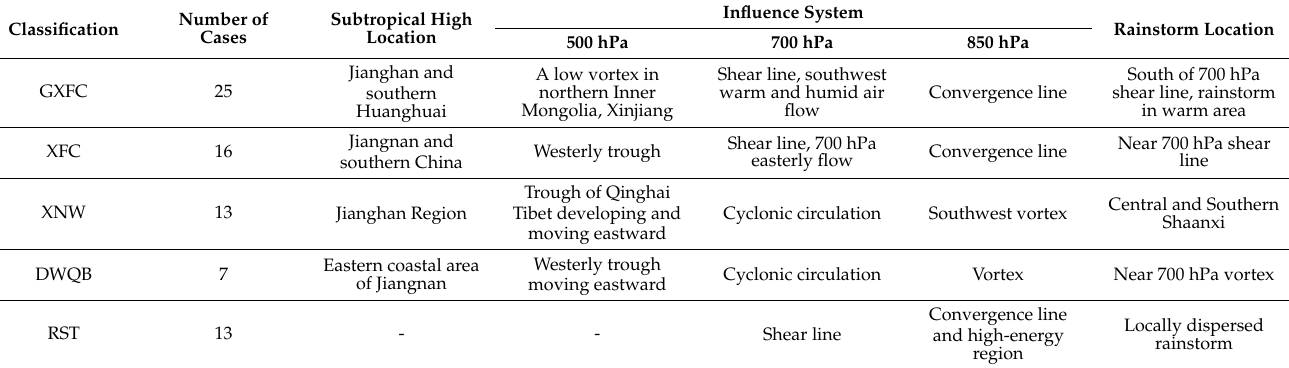
Table 1. Circulation classification of rainstorm weather in Qinling and their surrounding